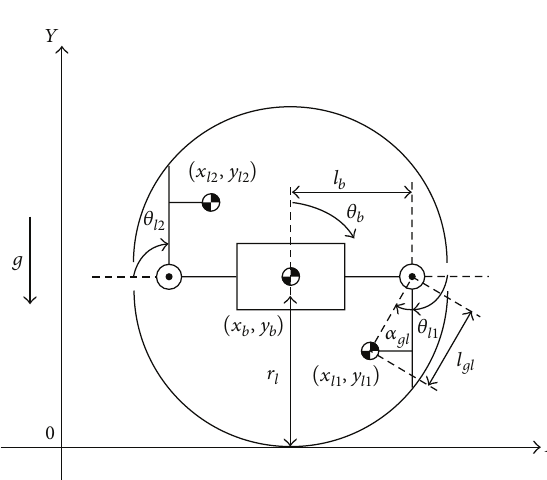
Figure 4: Model diagram of the rolling huntsman-spider-inspired quadruped robot. The model diagram describes planar rolling locomotion on the quadruped robot in the vertical two-dimensional surface, and its 𝑋 -axis describes the flat